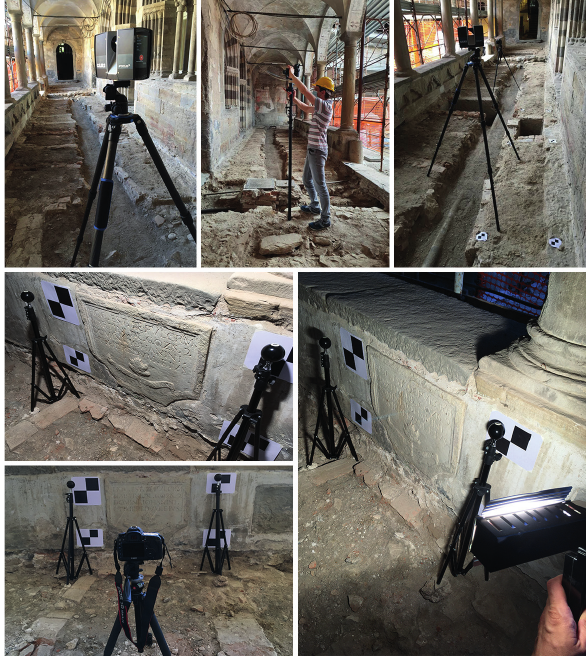
Figure 12. Phase 02 : the point clouds by 3D laser scanning and digital photogrammetry (the tombs after the